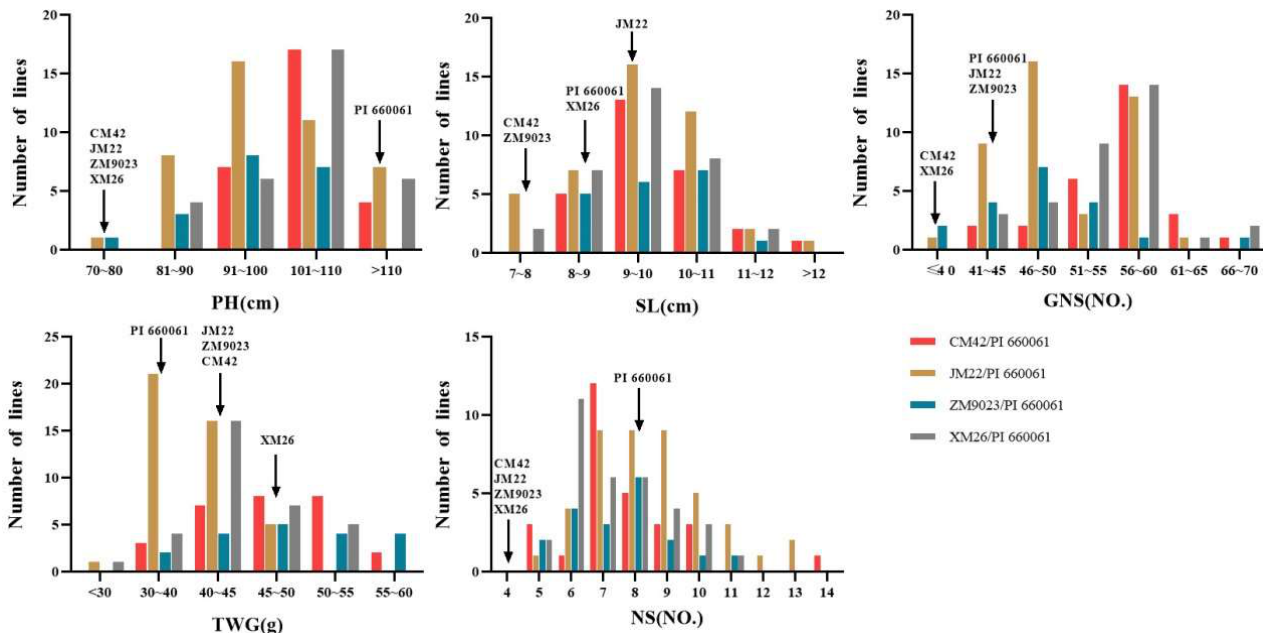
Figure 6. Frequency distributions of agronomic traits for the 123 ILs from the four populations. plant height (PH); spike length (SL); grain number per spike (GNS); thousand-grain weight (TGW); number of spikes (NS).